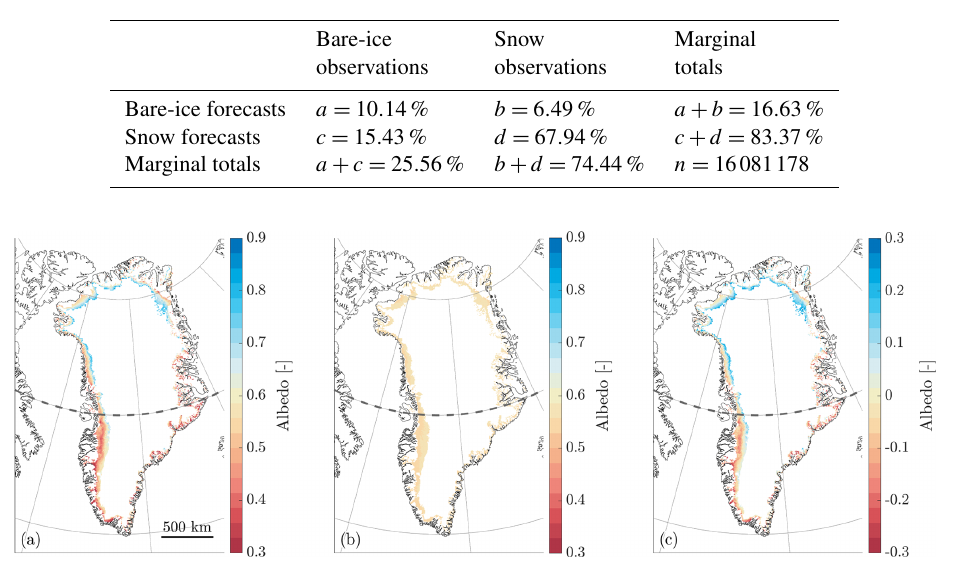
Table 1. Contingency table of forecasts (MAR) and observations (MODIS) in terms of determining either bare ice or snow. Bare ice both forecast and observed is a hit ( a ), bare ice forecast but snow observed is a false alarm ( b ), snow forecast but bare ice observed is a miss ( c ), and snow both forecast and observed is a correct rejection ( d ). Results are shown as a percentage of the total number of observations ( n ).